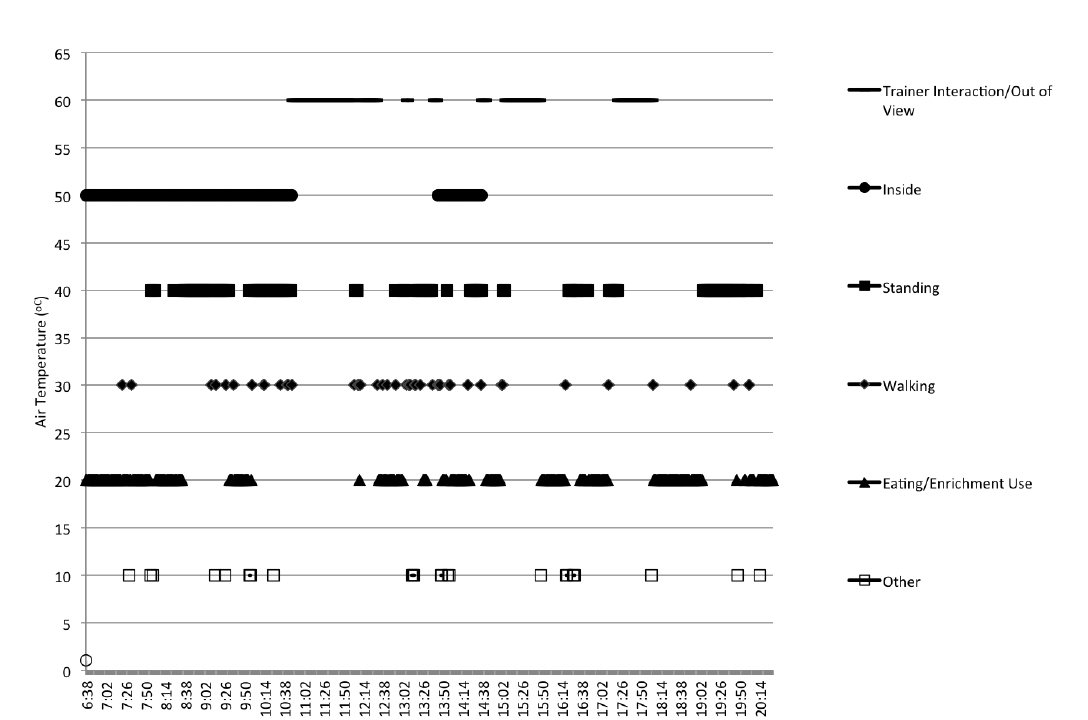
Figure 3. Nocturnal activity time budgets for each elephant and observation period, shown as a stacked chart. All observation periods were 10 hrs long and started at 20:30. Sunset and sunrise times for these dates in 2011: May 26 - 27, 20:18 – 06:35 hr. May 23 – 24, 20:16 – 06:36 hr.